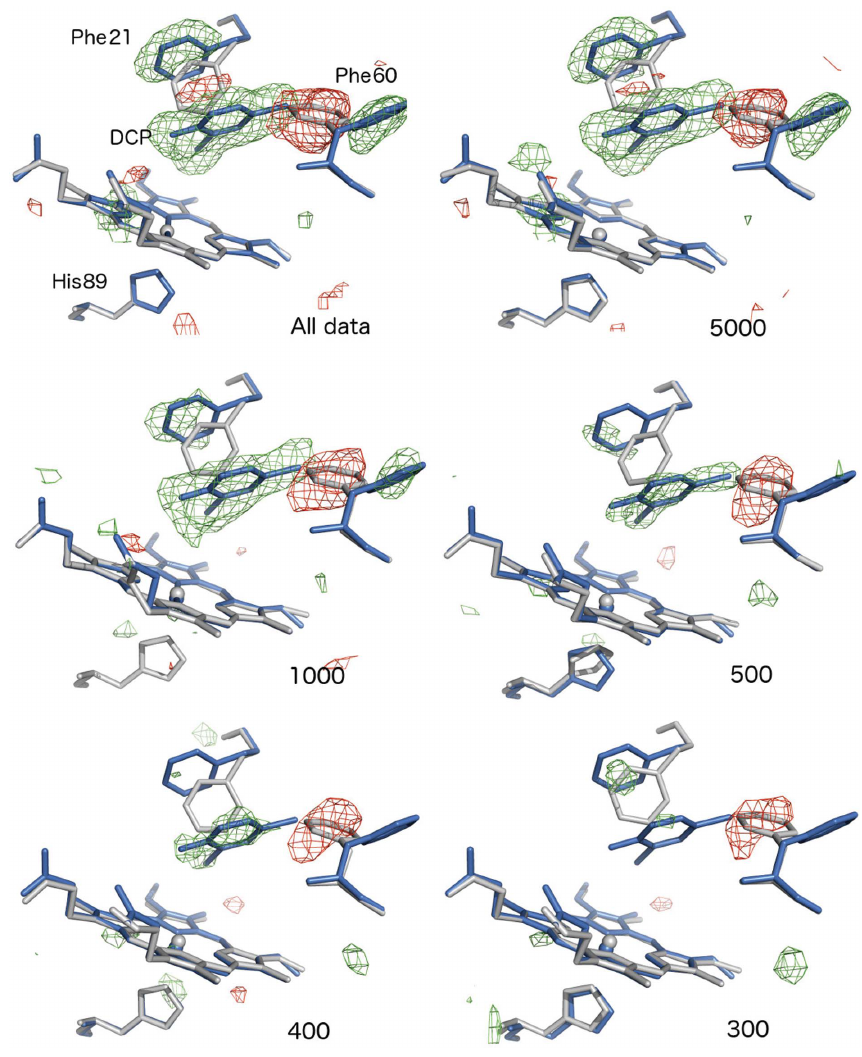
Figure 4 Difference map features produced by simulated-annealing refinement against ligand-free native structures clearly reveal ligand binding and active-site rearrangements in the absence of the risk of model bias. F o (cid:3) F c OMIT maps, contoured at 3 (cid:5) , are shown for DCP data subsets refined versus the native DHP structure. In each case, the native DHP structure from OMIT refinement versus a particular subset is shown in grey, while the superimposed structure of the ligand complex is shown in blue. Positive difference map features are shown in green, with negative features in red. Note that the flips of Phe21 and Phe60 to accommodate ligand binding, together with the ligand density itself, are very clearly defined in the data set obtained from all data and this is maintained in the 5000- image subset. Clear OMIT map features are apparent for Phe60 and DCP in data sets with as few as 400 images, while this was no longer the case in the 300-image